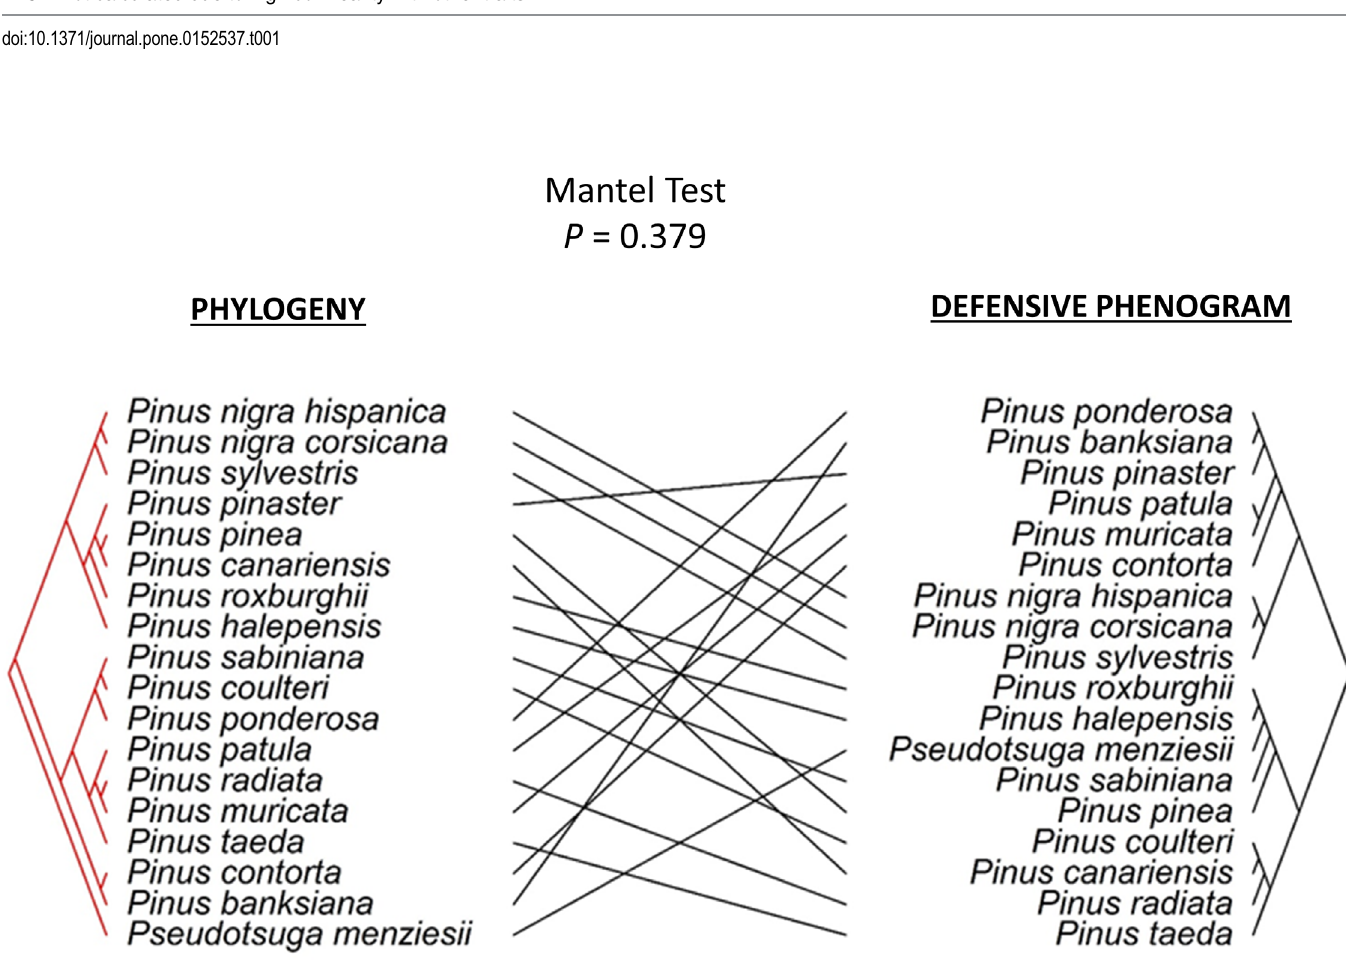
Fig 2. Scheme showing the lack of congruence between the molecular phylogeny of pine trees based on molecular markers by Eckert & Hall [44] and the defense phenogram constructed from phenotypic functional defensive traits in this study (Mantel Test, P =